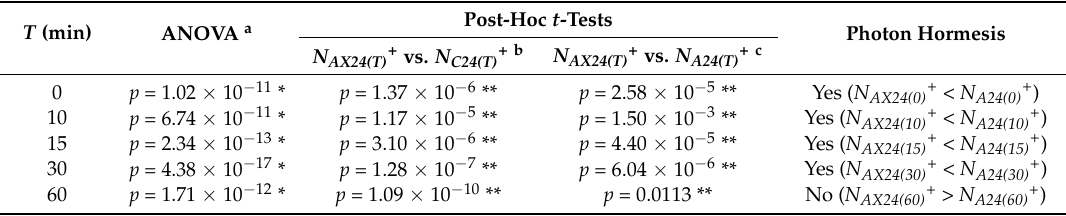
Table 1. ANOVA and post-hoc t-test results obtained among N AX24(T) + , N A24(T) + , and N C24(T) + , with time gaps T = 0, 10, 15, 30, or 60 (min) between the alpha-particle and X-ray irradiations, and with apoptotic counts determined at H = 24 (hpf).